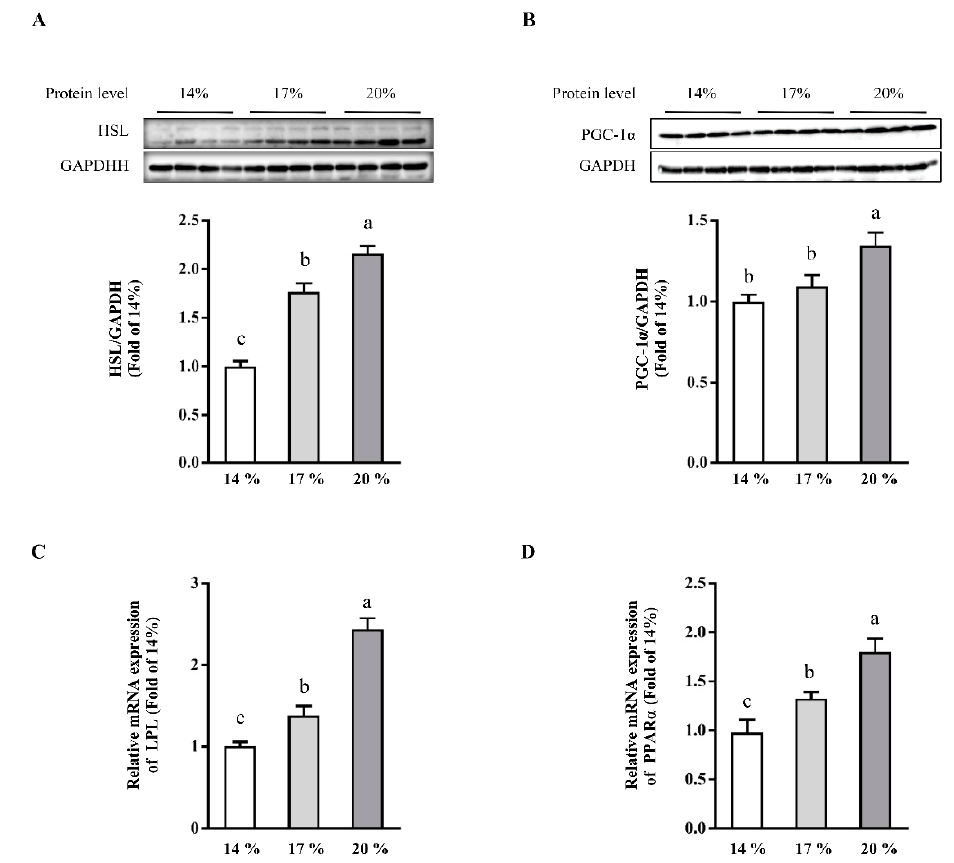
Figure 3. Effects of dietary crude protein level on hepatic lipolysis and lipid oxidation. Immunoblot analysis of HSL ( A ) and PGC-1 α ( B ) protein abundances, LPL ( C ), and PPAR α ( D ) mRNA abundance in the liver of weaned piglets fed different dietary crude protein. Values are means ± SEMs, n = 4 (protein abundance) or 6 (mRNA expression). Means without a common letter differ, p < 0.05. HSL, hormone-sensitive lipase; PGC-1 α , peroxisome proliferator-activated receptor gamma coactivator 1-alpha; LPL, lipoprotein lipase; PPAR α , peroxisome proliferator-activated receptor alpha. Animals 2021 , 11 , x FOR PEER REVIEW